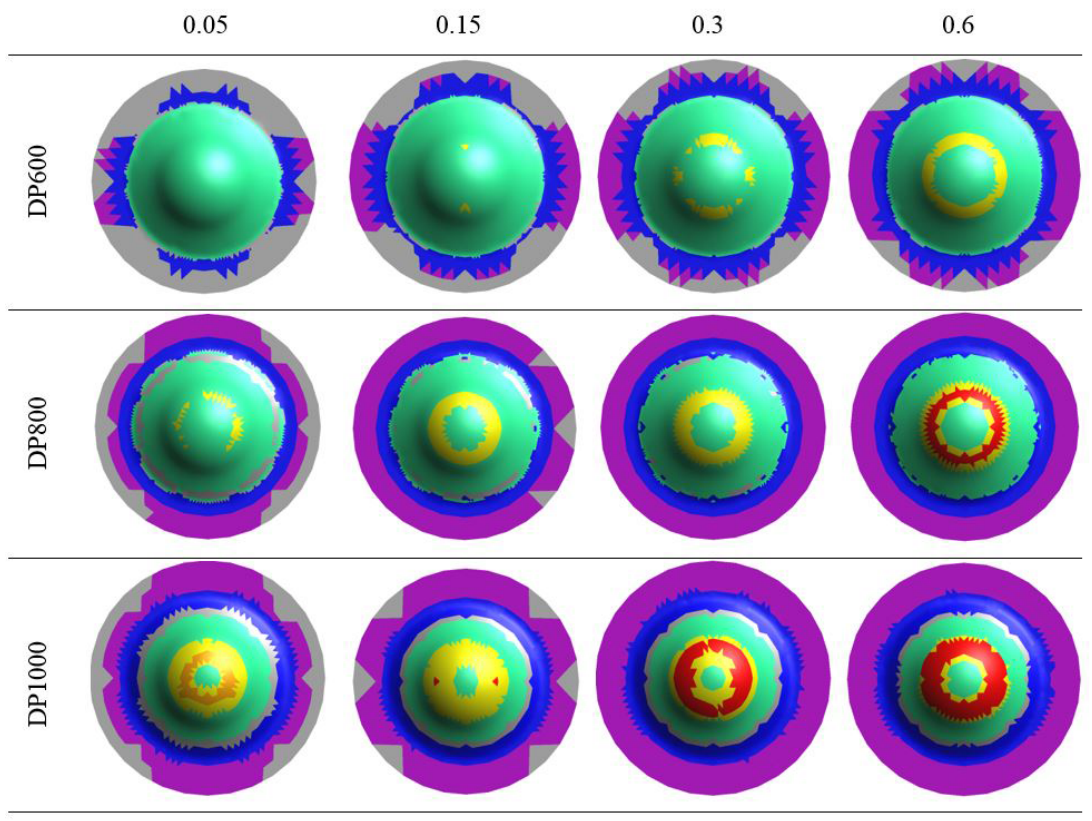
Figure 4. Comparison of formability